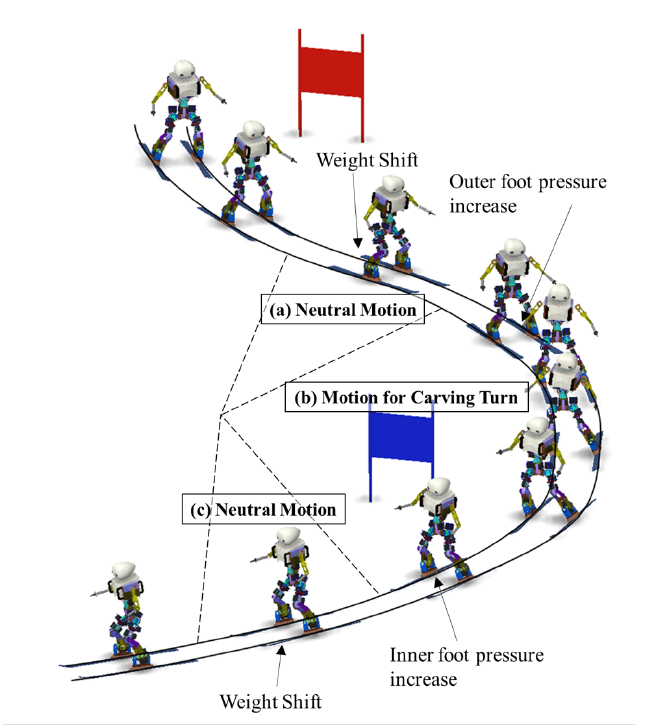
Figure 7. Motion and role of each turning section for DIANA’s carved